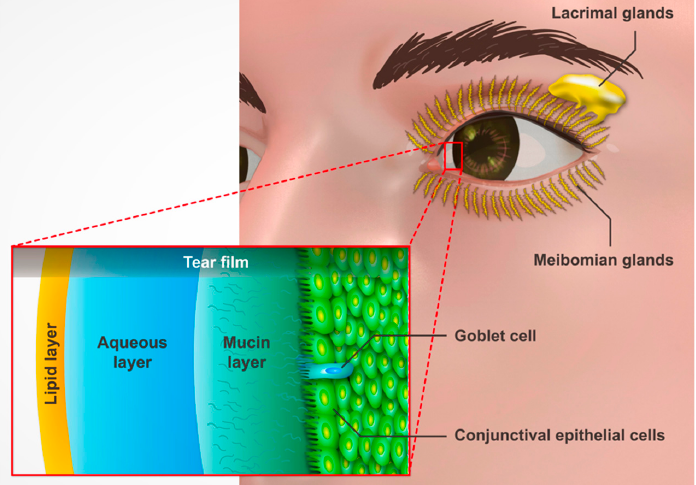
Figure 3. Structures involved in the production of tear film.